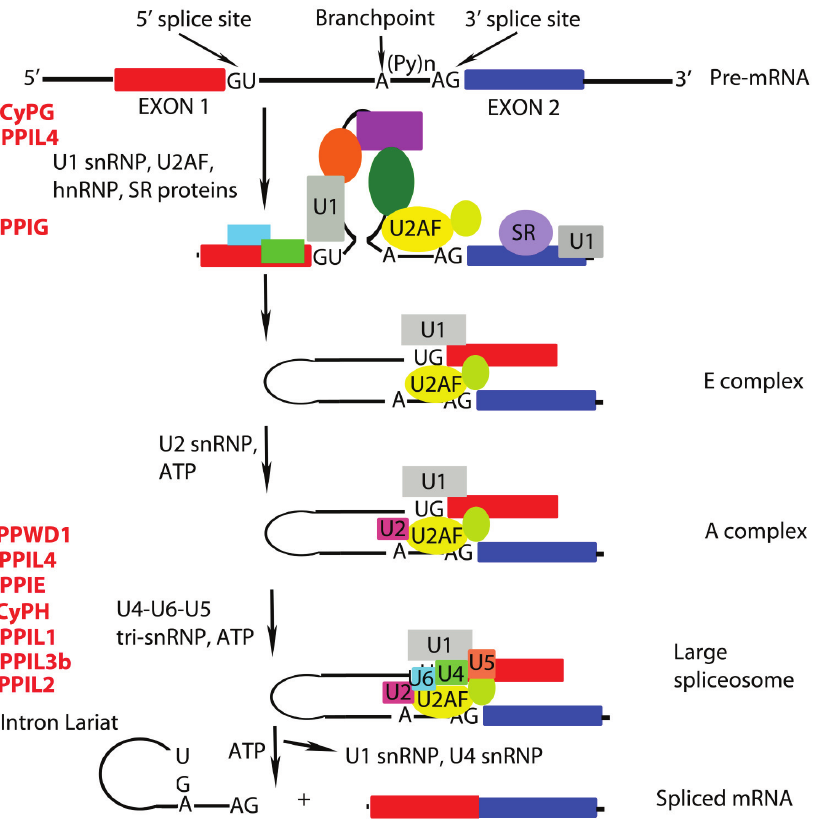
Figure 1. A simplified schematic of alternative splicing is shown. Splicing is directed by the GU dinucleotide at the 5' splice site of the intron and the AG nucleotide at the 3' splice